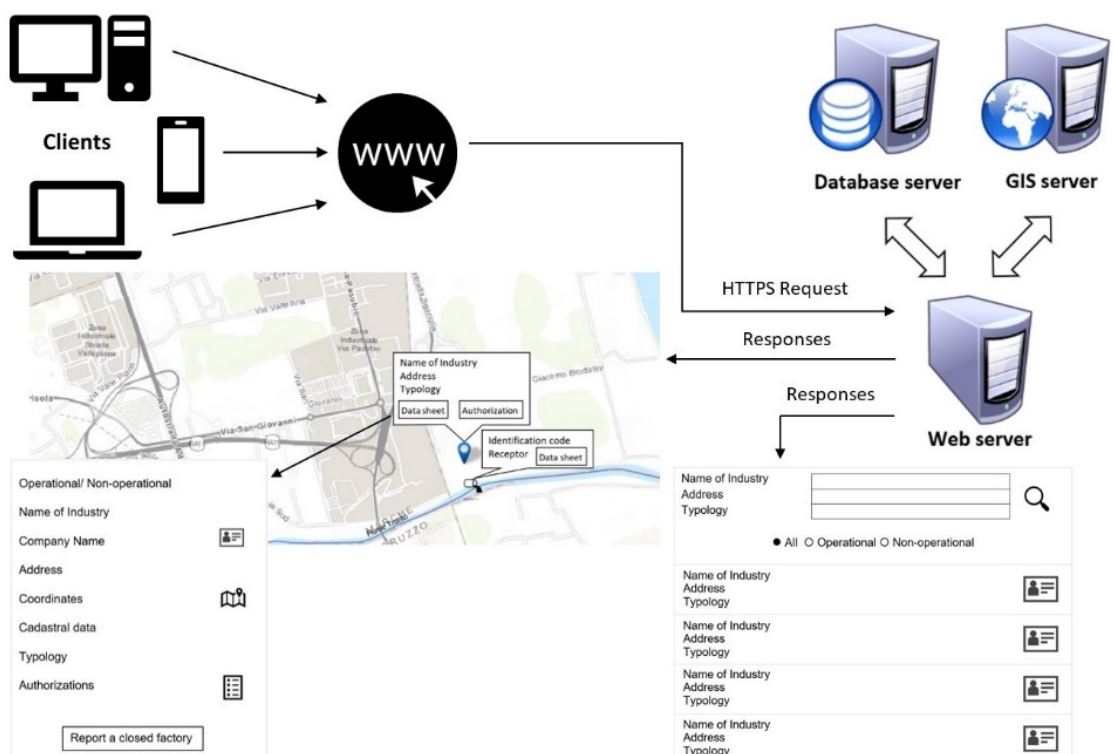
Figure 1. The overall layout of the framework.